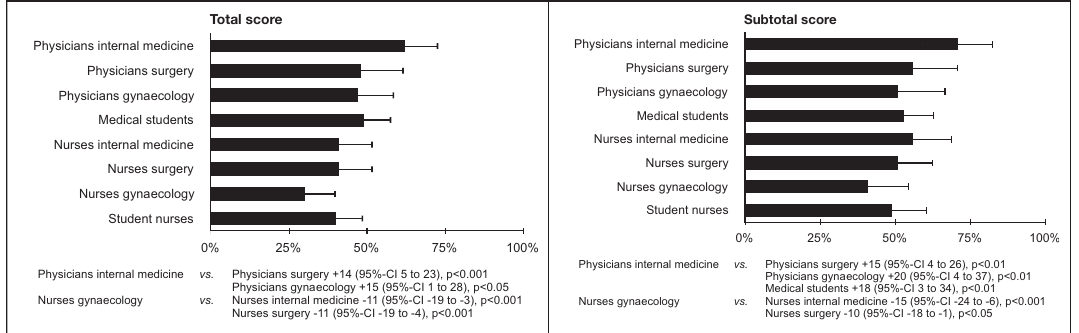
Total and subtotal scores of different study groups (mean ± SD) with relevant statistics (ANOVA with Tukey-Kramer multiple comparisons test) in medical house staff and nursing house staff